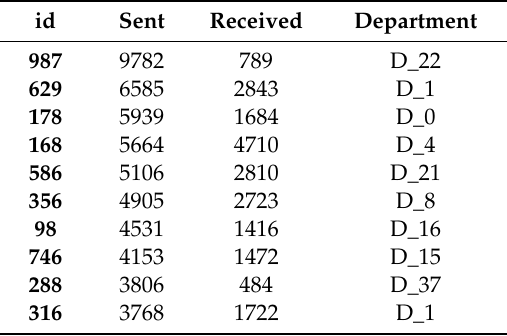
Table 2. Individual level statistics (top 10 in emails sent).